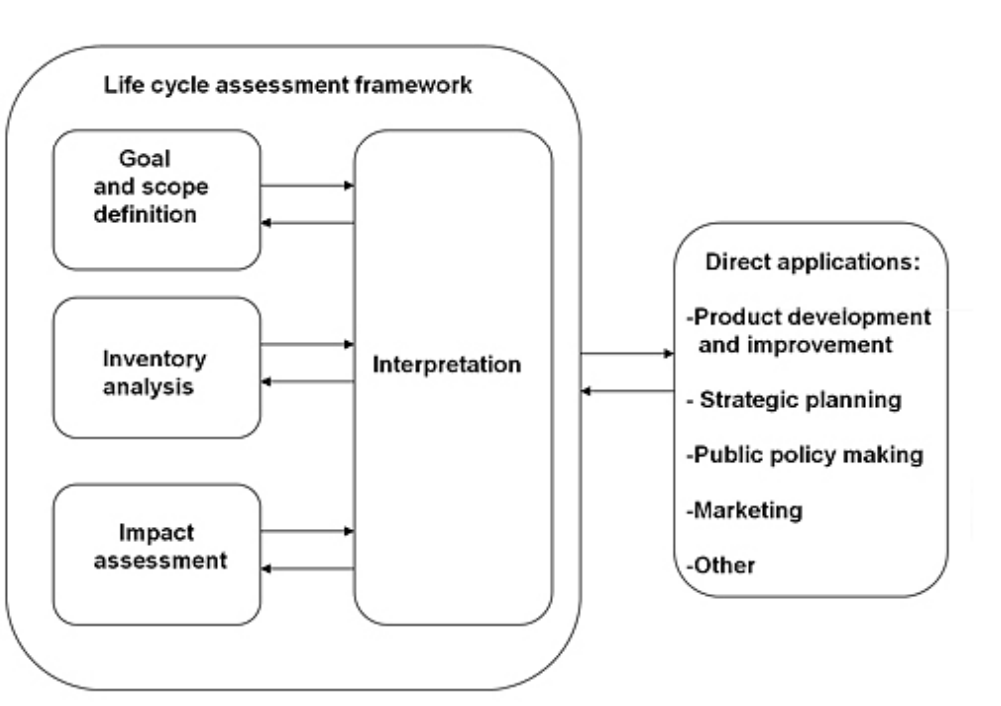
Figure 3: LCA phases according to ISO 14040:2006